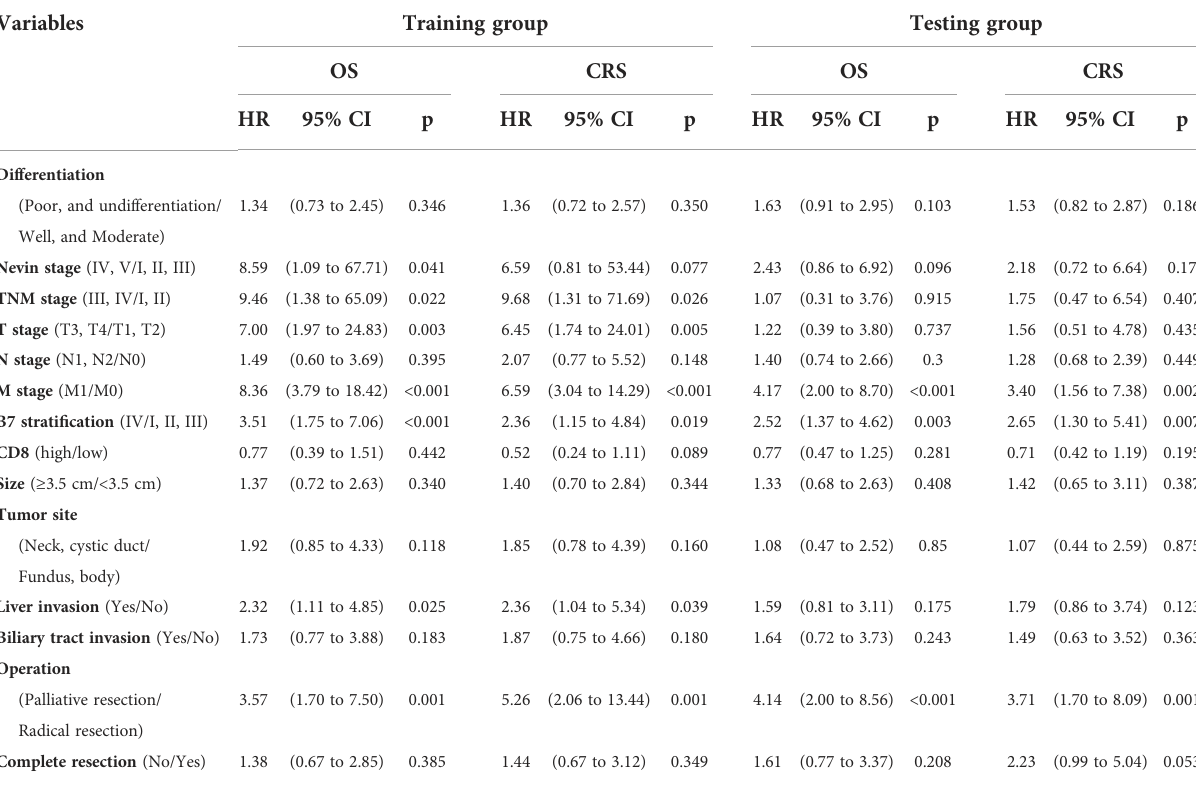
TABLE 1 Multivariate analysis of clinicopathological parameters associated with OS and CRS based on B7 strati fi